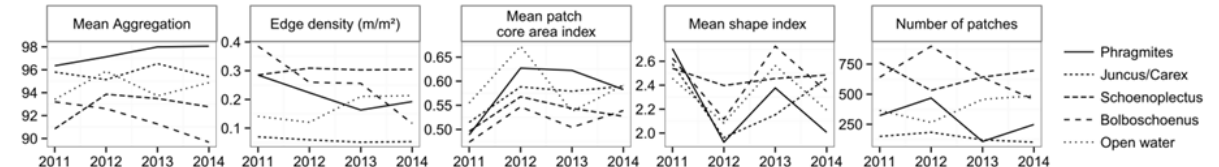
Figure 7. Development of geometrical properties of vegetation patches in the study area by class measure from 2011 to